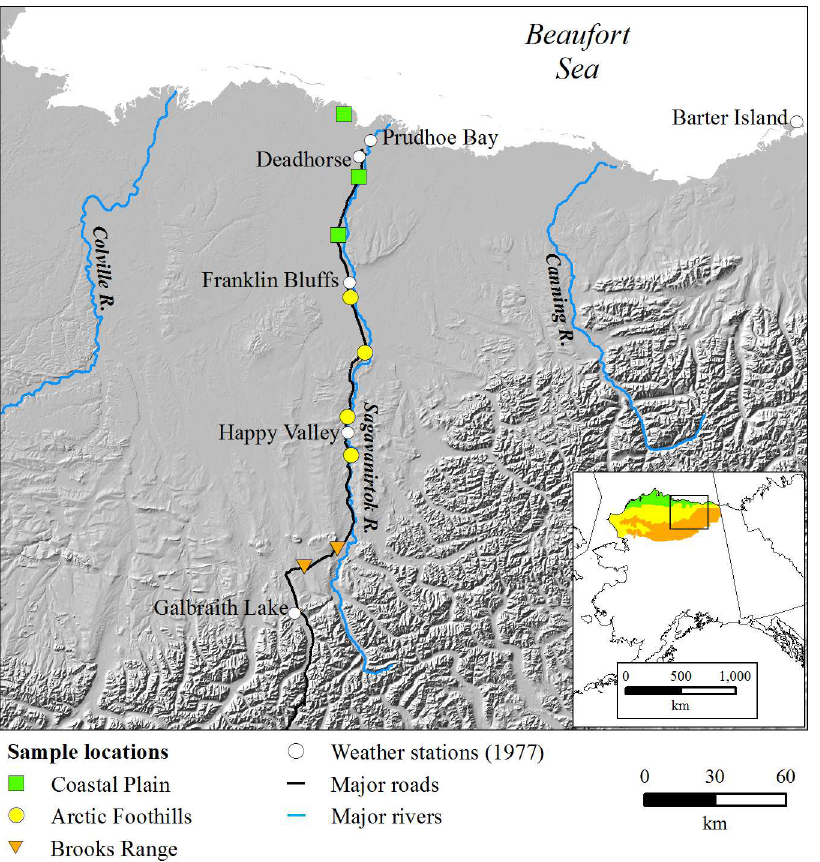
Fig 1. The locations of weather stations and sampling locations to monitor nitrogen content of caribou ( Rangifer tarandus ) forages and ambient air temperatures throughout the growing seasons of 1977 and 2011–13in three ecoregions (Coastal Plain, Foothills, and Brooks Range) along the Dalton Highway, North Slope of the Brooks Range, Alaska; distribution of the Arctic ecoregions in Alaska are shown in the